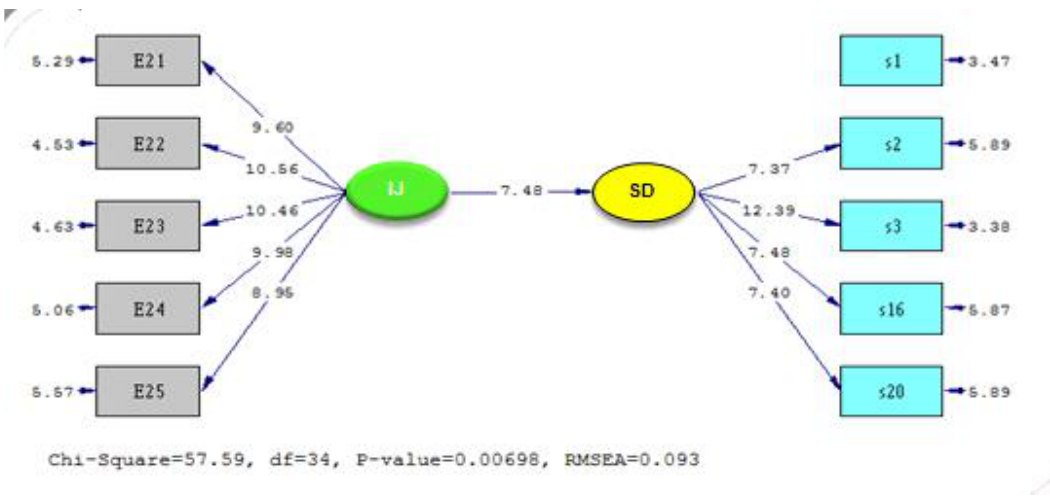
Fig. 5: Confirmatory Factor Analysis of First sub hypothesis of the Research (Standard Estimation Numbers)